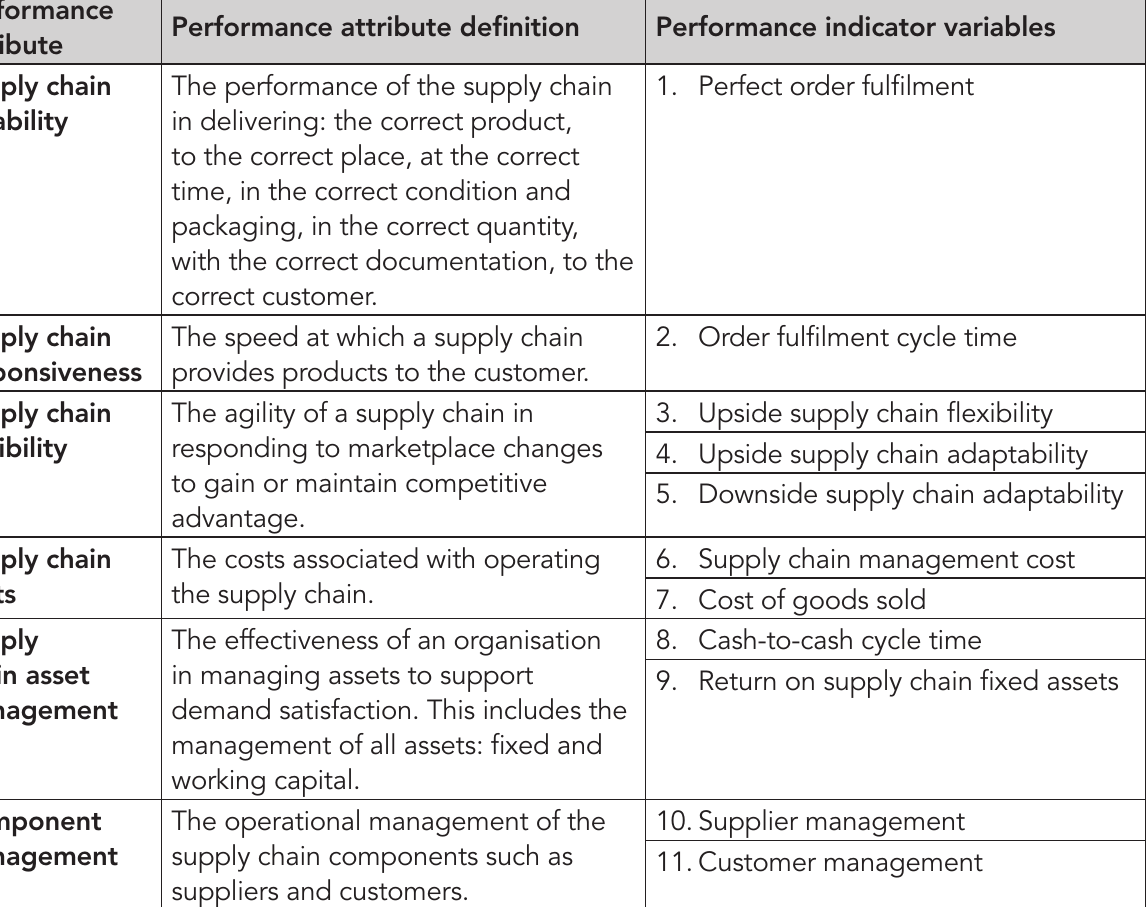
Table 3: Definitions for supply chain performance attributes (Supply Chain Council, 2011) Performance